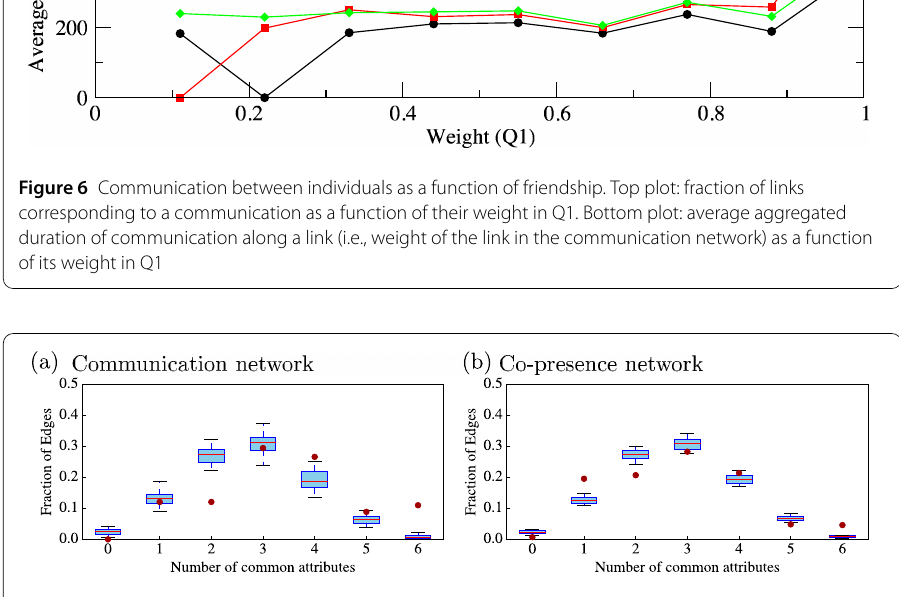
Figure 7 Distribution of the number of common attributes on an edge, compared with a null model with reshuffled attributes. Attributes: Cohort class, Age, Gender, Nationality, GPA and First Language. Boxplot: Whiskers—5th, 10th and 90th, 95th percentiles; box—25th and 75th